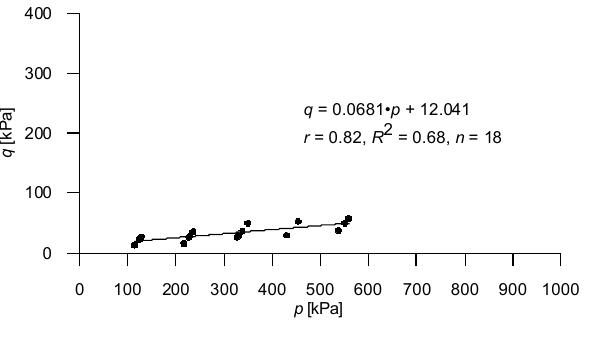
Figure 16: Result of strength tests for soil B-1.